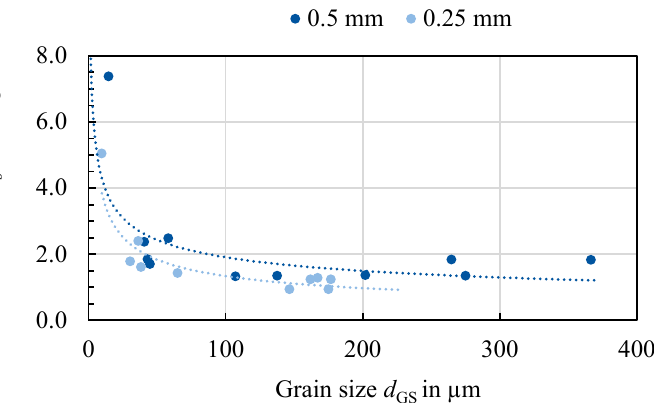
Figure 5. Iron loss at 1.0 T and 50 Hz as a function of grain size for all studied materials sorted by sheet thickness.